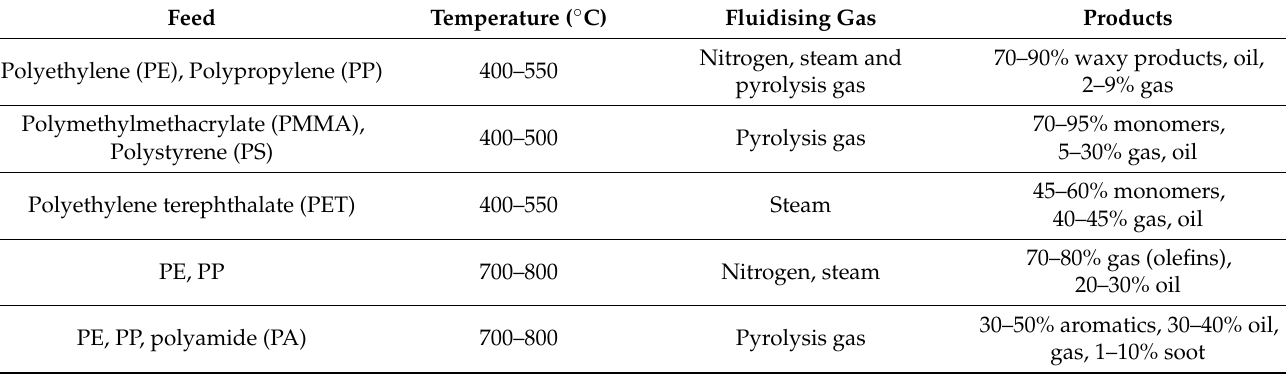
Table 4. Results of pyrolysis of different plastics by Kaminsky [Adapted from 41].